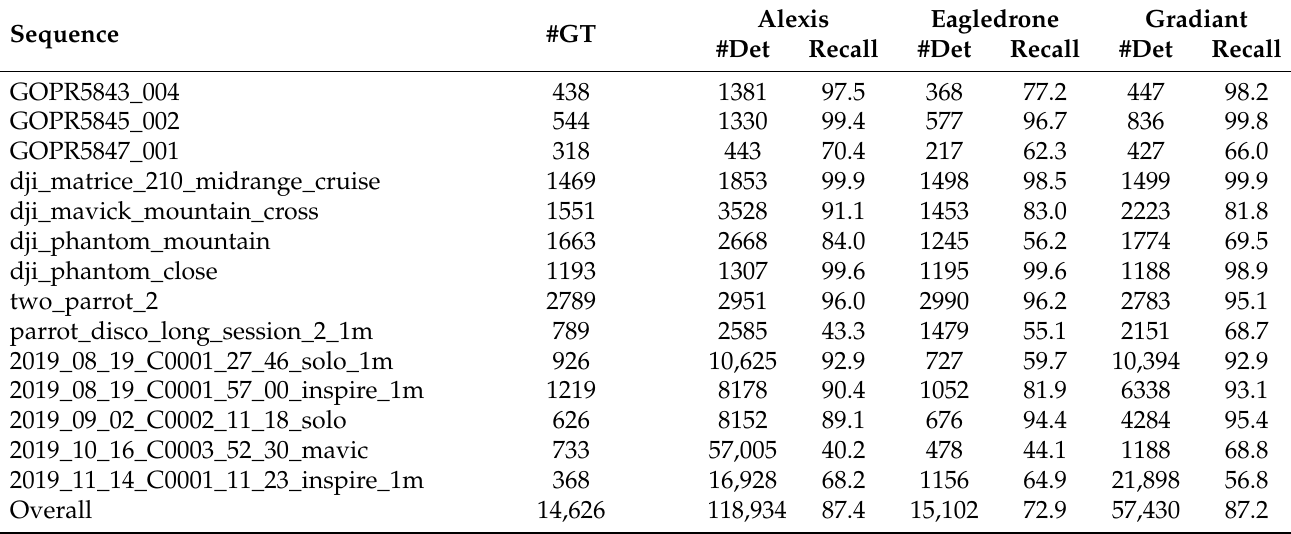
Table 6. Comparison of detection results in terms of number of submitted detections (#Det) and resulting recall.